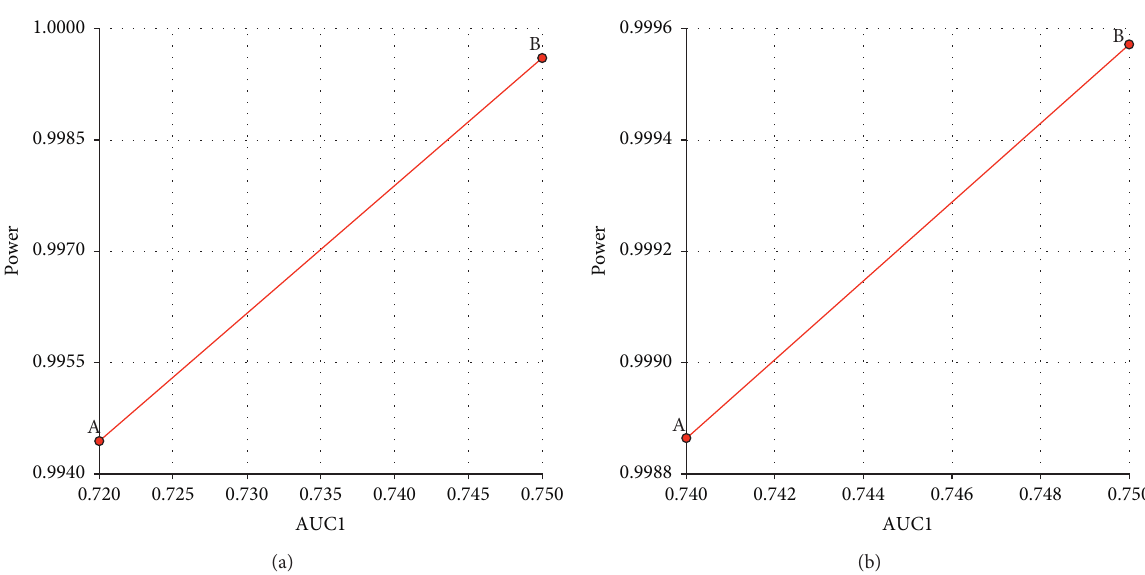
Figure 5: Power analysis results for the development cohort and validation cohort. (a) Development cohort; (b) validation cohort; (A) classification tree model; (B) logistic regression